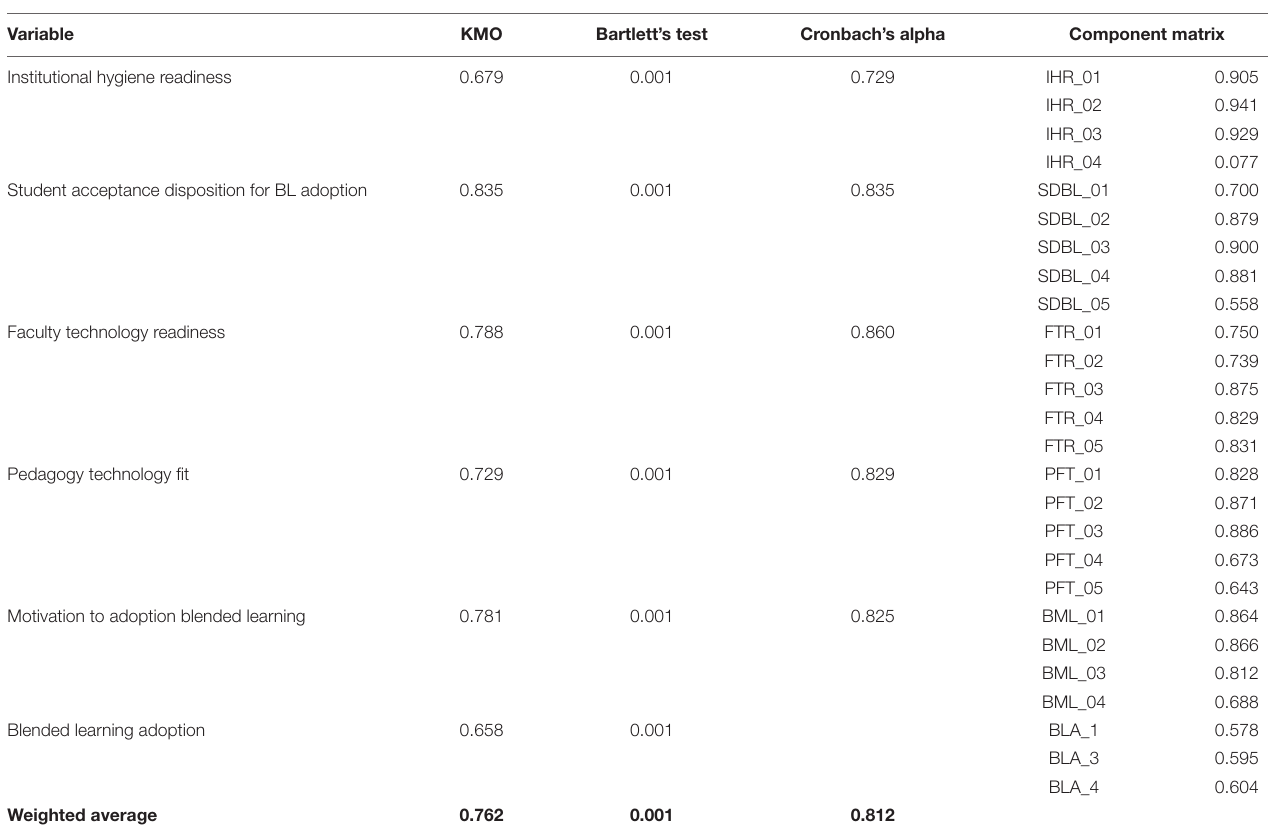
TABLE 7 | KMO, Bartlett’s test, Cronbach’s alpha and component